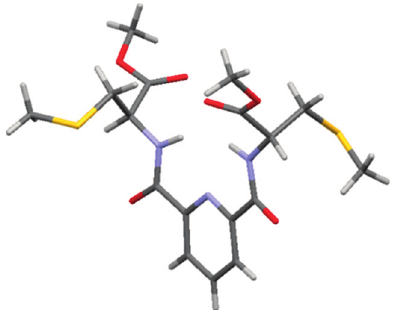
Figure 3. X-Ray crystal structure of pyridine-2,6-dicarboxylic acid bis( S -methyl- L -cysteine methyl ester)carboxamide ( 2 ). Carbon atoms are shown in grey, oxygen in red, nitrogen in lilac, sulfur in yellow and hydrogen in white. CCDC-1017988 contains the full